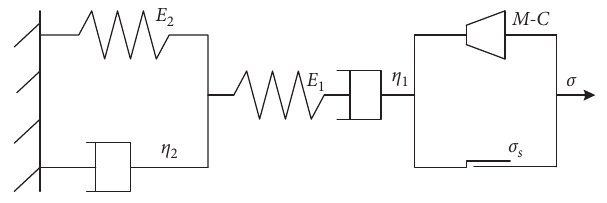
Figure 12: Viscoelastic